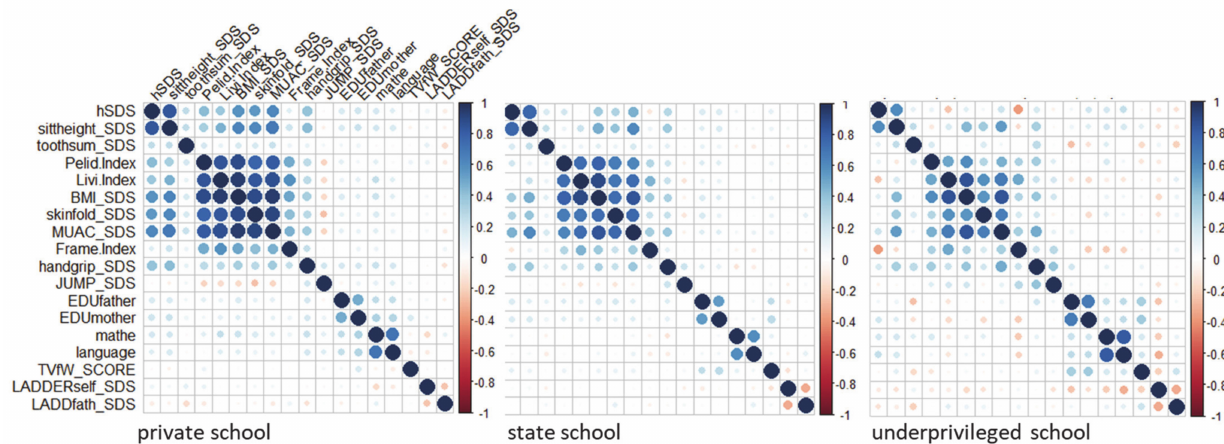
Figure 2. Correlation matrices of 18 variables of three different school types in Kupang (West-Timor) depicts the correlation matrices of the private, the state, and the underprivileged schoolchildren and highlights the differences between the school types. High correlations existed between the two measures of length (total body height and sitting height), and between the five measures related to the nutritional state. The correlations between height and the measures of the nutritional state however, were low and strongly depended on the school type (Table 3). The correlations between height SDS and variables related to the nutritional state seemed to almost completely disappear in the children of the underprivileged school. Also the interaction of the five measures of the nutritional state significantly declined in the underprivileged school